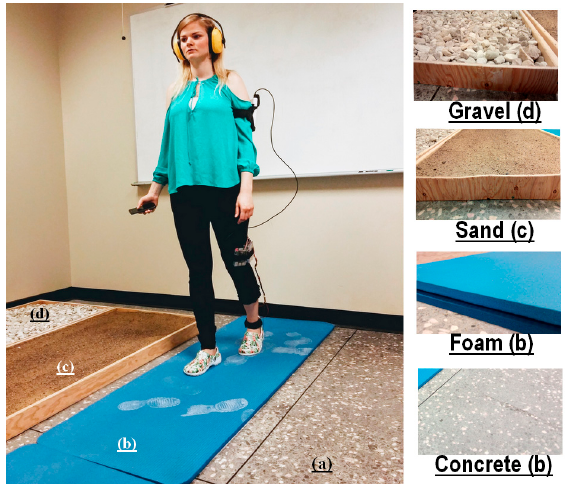
Table 1. Participant’s